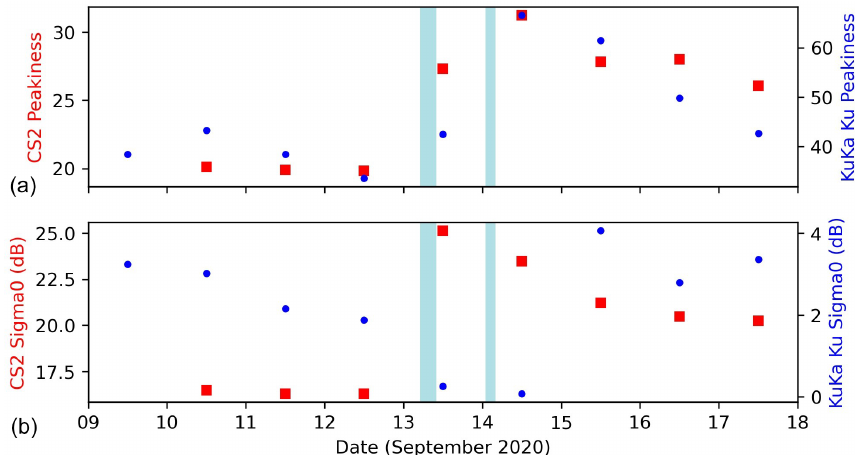
Figure 8. Time series of peakiness (a) and sigma0 (b) for CryoSat-2 (red squares) and KuKa Ku-band data (blue circles) averaged over 24h periods. The blue sections indicate periods of